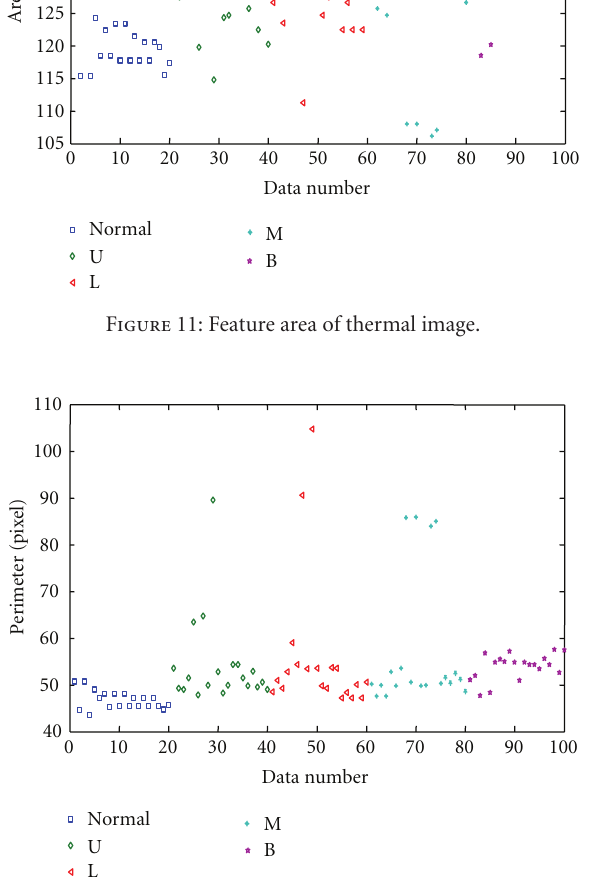
Figure 14: RMS vibration.